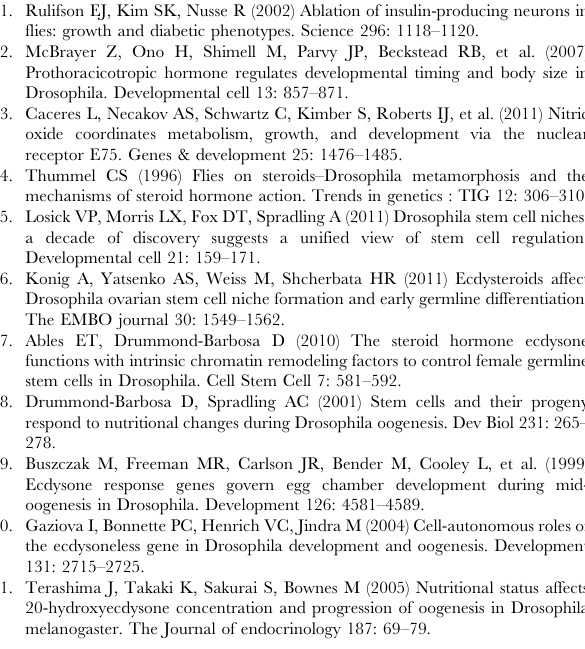
Figure S2 c587 GAL4 drives transgene expression in the somatic cells of the testis. c587 GAL4::UAS-LacZ 29 u C day 7. c587 GAL4 drives transgene expression in somatic cyst cells of the testis (arrow) and cells within the sheath layer (arrowhead). Green: somatic cells (anti-Tj), magenta: fusome (anti-Hts). Scale bar: 10 m m.